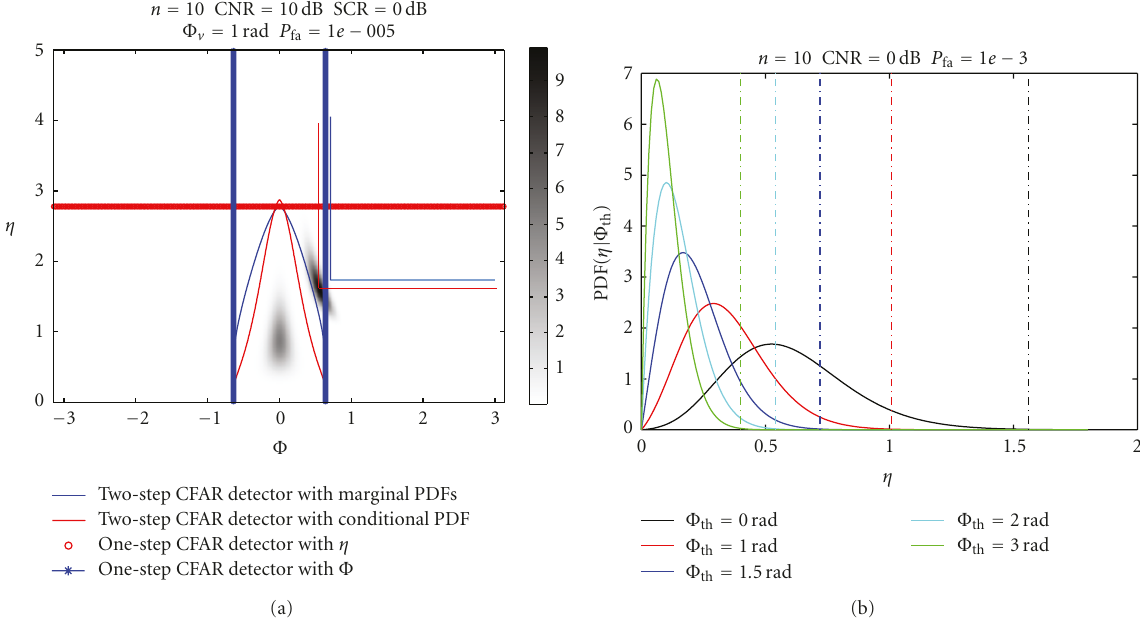
Figure 5: (a) Threshold curves of ATI detectors for n = 10, P fa = 1 e − 5, CNR = 10 dB, SCR = 0dB, and Φ v = 1rad, (one-step CFAR detector with Φ and η , two-step CFAR detector with conditional PDF, and two-step CFAR detector with marginal PDFs); (b) the PDF of η as a function of phase and corresponding